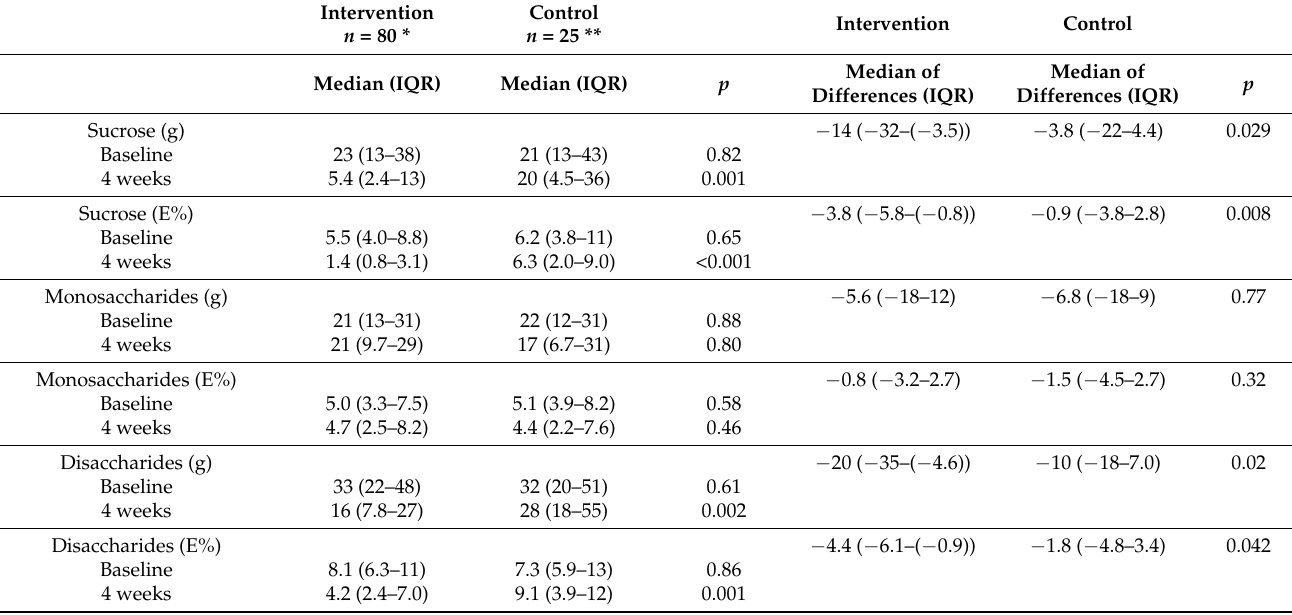
Table 3. Sugar and starch intake before and after the SSRD